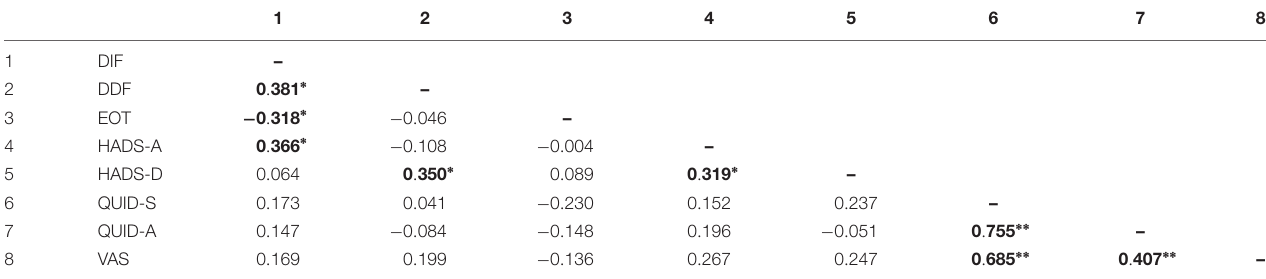
TABLE 6 | Significant Pearson correlation coefficients r : associations between alexithymia, psychological distress and pain in patients with alexithymia ( n = 40).